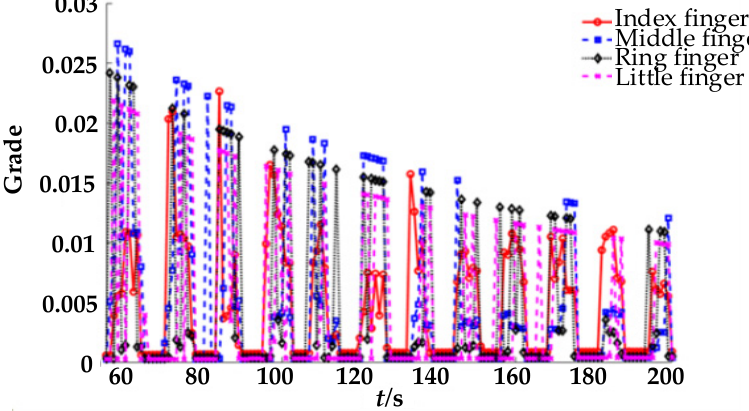
Figure 12. Muscle strength score of four fingers.